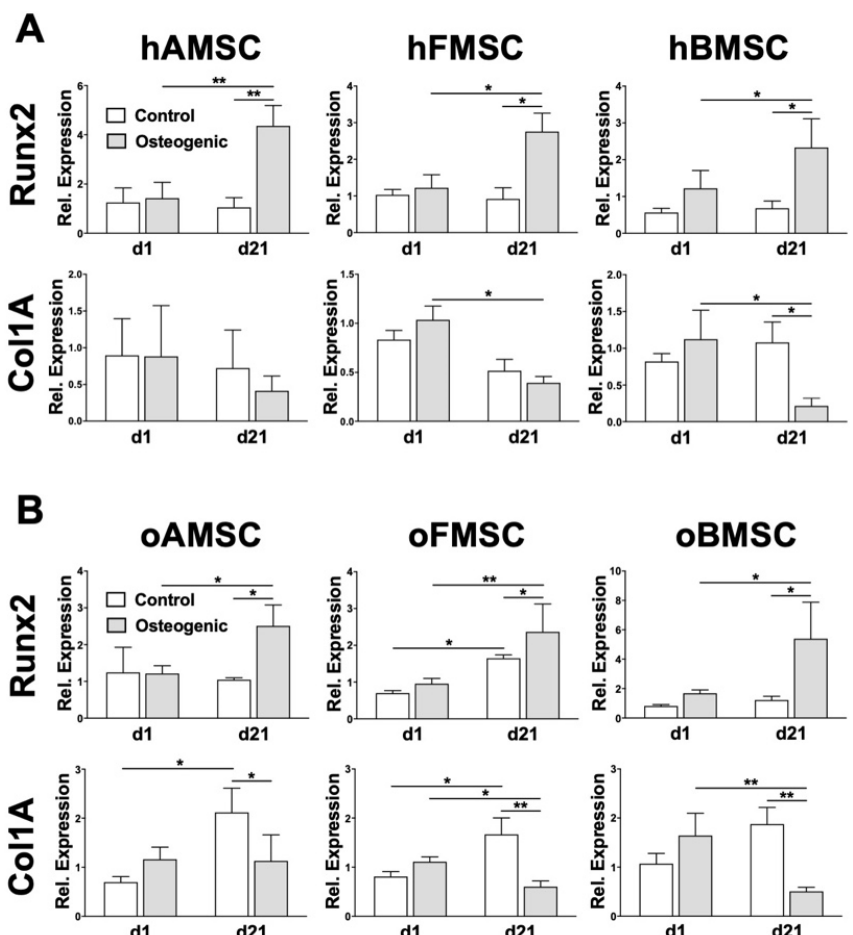
Figure 7. MSCs from ( A ) human and ( B ) ovine sources expressed common osteogenic gene marker Col1A and Runx2. MSCs from three corresponding human and ovine sources were induced towards the osteogenic lineage for 21 days. Culturing medium without any supplements was used as